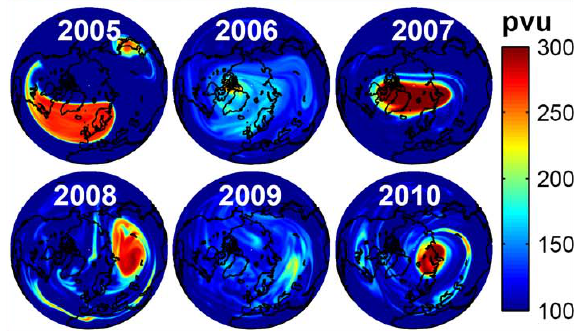
Fig. 7. Maps of potential vorticity (1PV units (pvu)) = 10 − 6 km 2 kg − 1 s − 1 ) calculated from ECMWF data on 15 March 2005–2010 at 675K. The maps also display the strength and position of polar vortex on 15 March in each